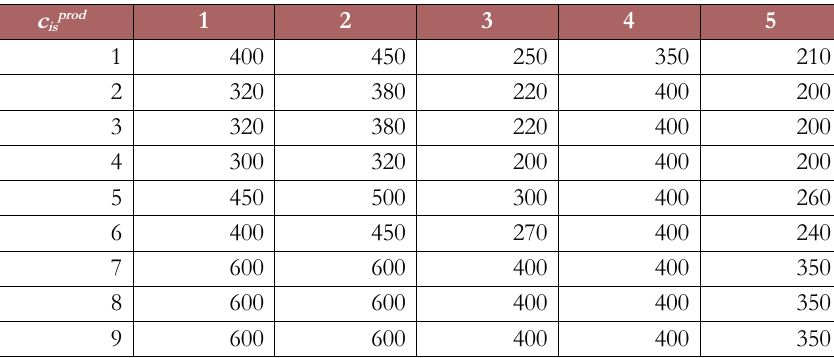
Table 3. The production cost of each parts manufactured in each country